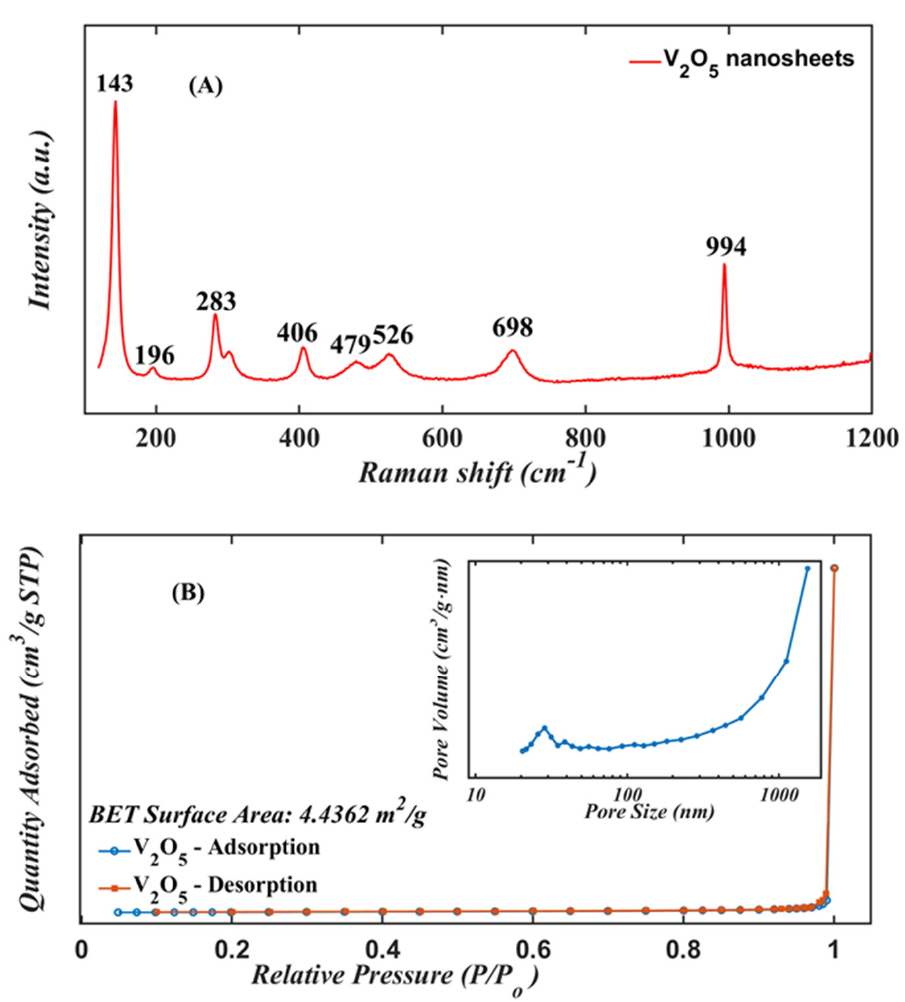
Figure 6. ( A ) Raman scattering and ( B ) BET curve of the V 2 O 5 nanosheets annealed at 500 ◦